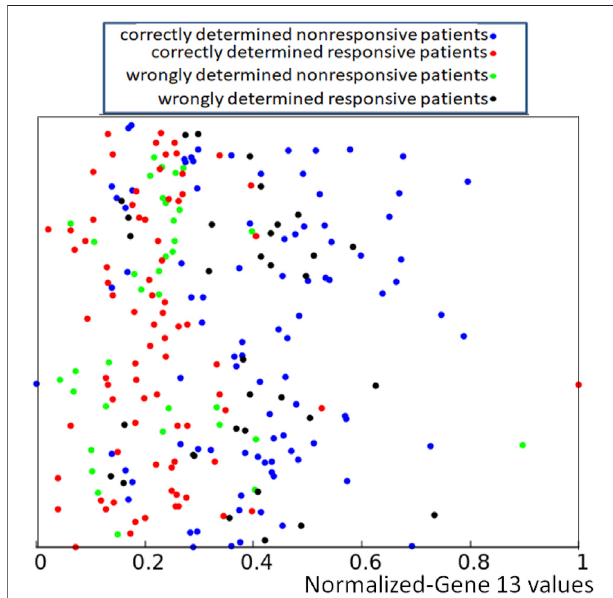
FIGURE5 | Location ofcorrect and incorrect predictionson theresult of drug therapy by a network of oscillators optimized for the RPS7 gene. The values of p 13, k are represented by the x-coordinate of marked points. The y-coordinate is randomly generated to differentiate points and is the same as in Figure 2